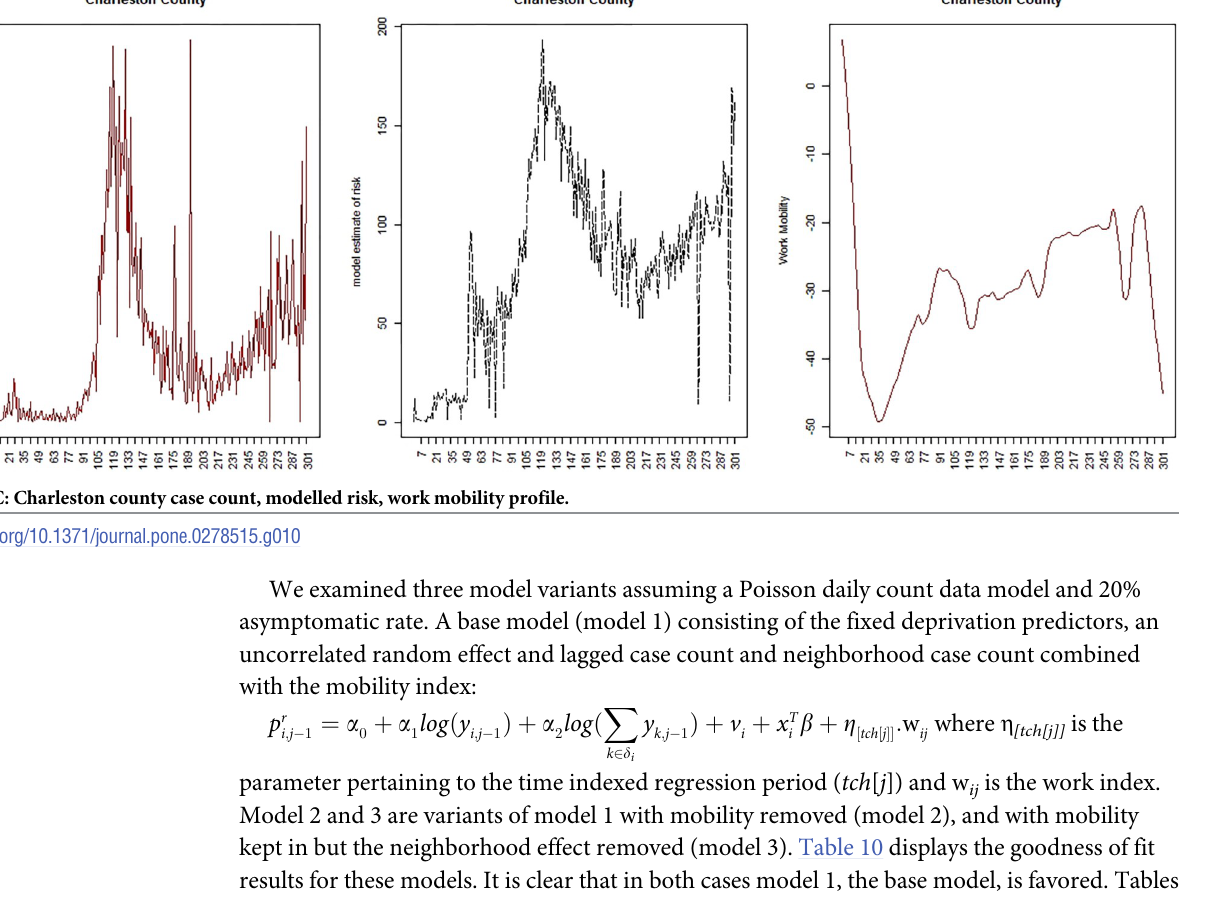
PLOS ONE | https://doi.org/10.1371/journal.pone.0278515 December22,